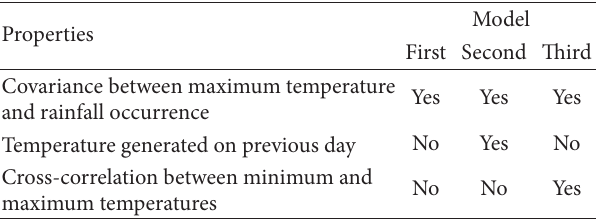
Table 1: Differences among models according to their